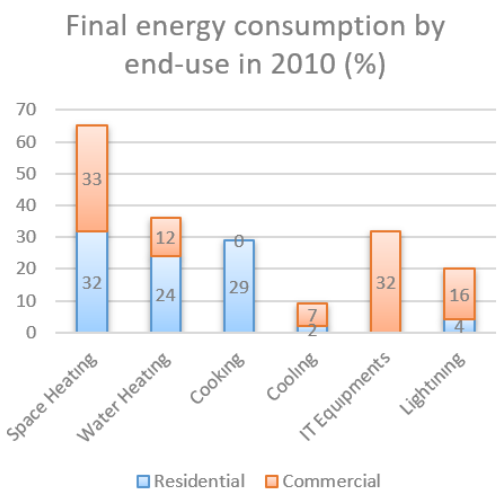
Figure 3. The chart shows the shares in the final energy consumption in residential and commercial use. Source: Adapted with modifications from IPCC